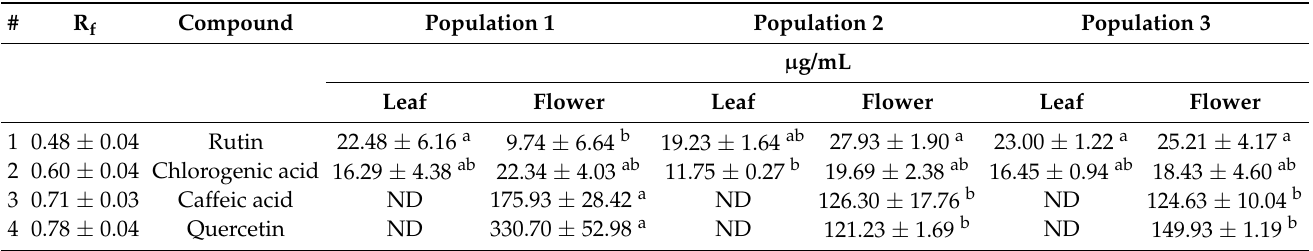
Table 4. Phenolic compounds identified by High-Performance Thin-Layer Chromatography (HPTLC) in ethanolic extracts from leaves and flowers of Cosmos sulphureus